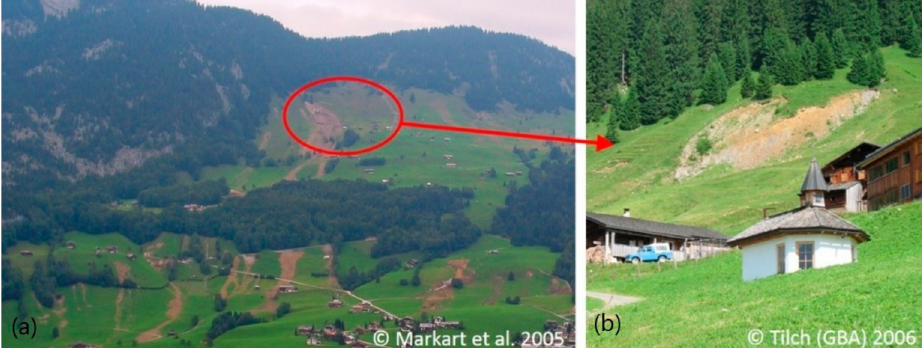
Figure 16. Field photos around the village of Au taken in august 2005 ( a ) and in field work 2006 ( b ).